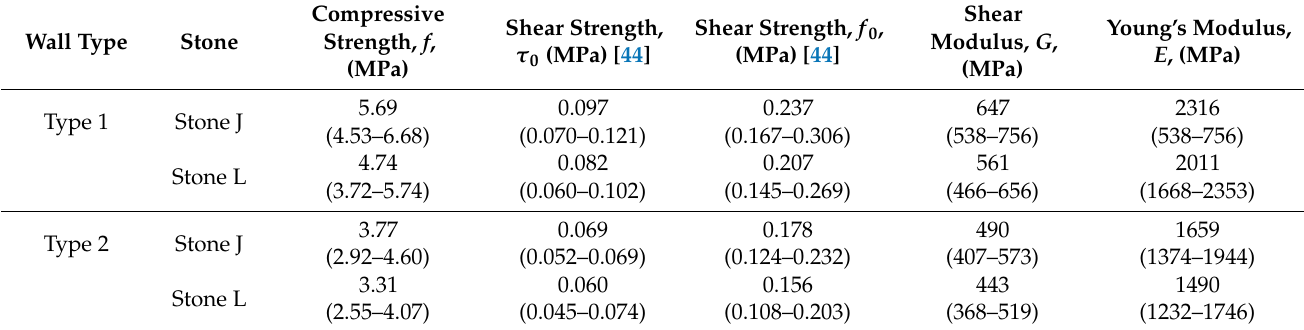
Table 4. Results of the assessment of the mechanical properties of the masonry